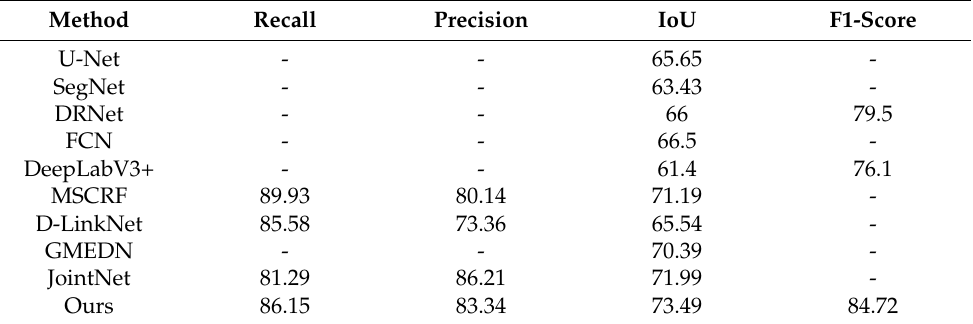
Table 2. Quantitative comparison results (%) among our method and other nine classical building extraction methods tested on the Massachusetts Building